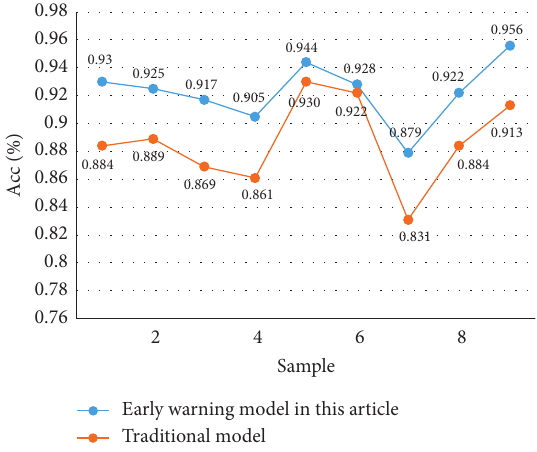
Figure 7: Early warning accuracy